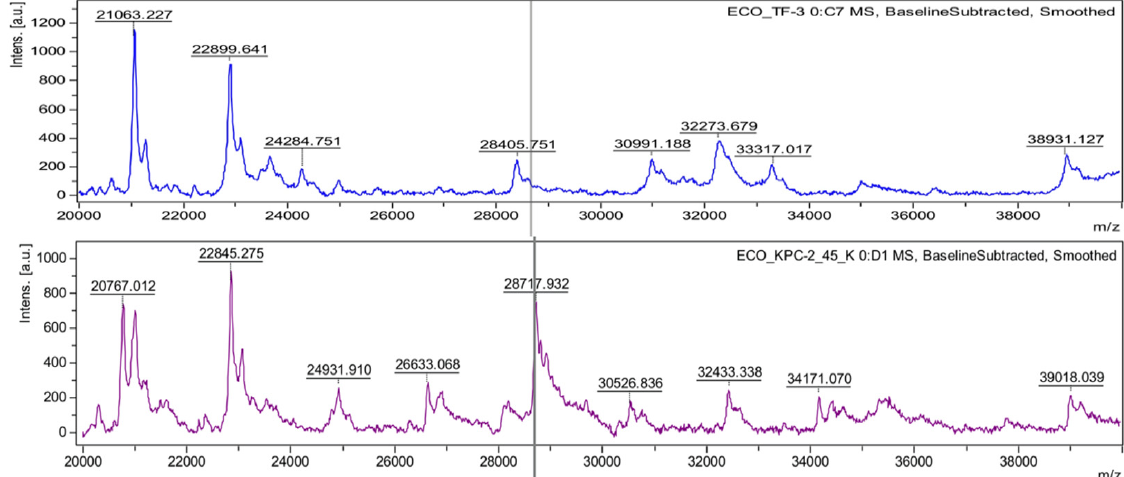
Figure 3. Identification of the KPC producer by using the KPC peak at 28718 m/z . Mass spectra were obtained from the lysates of drug-susceptible ( upper ) and carbapenem-resistant ( bottom ) E. coli conferred by the KPC-2 enzyme. A KPC peak is presented near the theoretical molecular weight of the KPC-2 polypeptide, with the gray vertical line, at 28718.13 m/z .